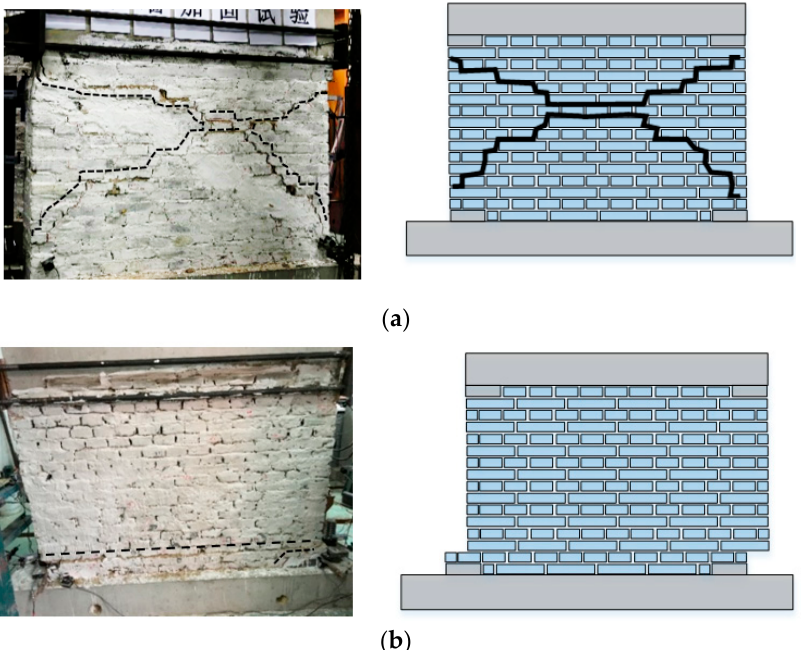
Figure 7. Failure modes of the walls: ( a ) Shear-compressive failure of the unstrengthened W1; ( b ) bed-joint slide of the strengthened walls.